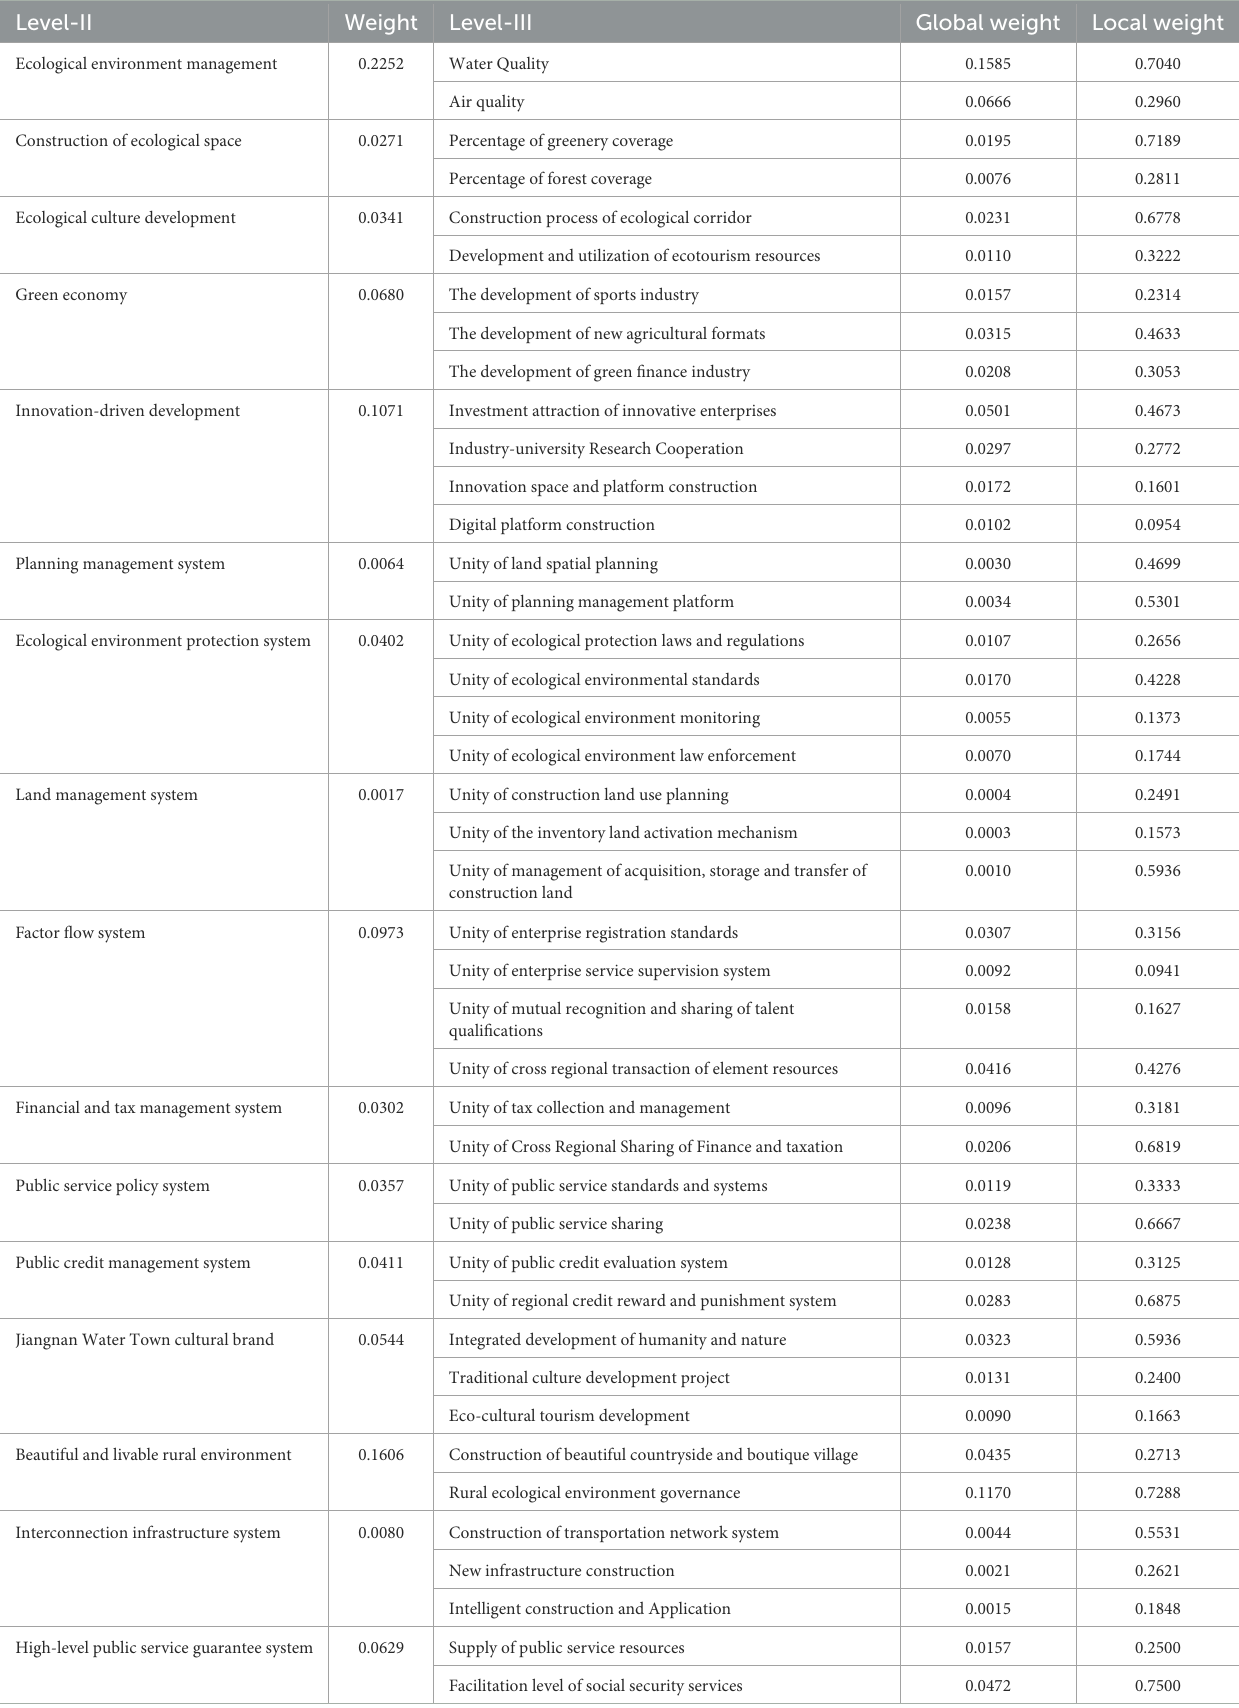
TABLE 3 Weight of high-quality development evaluation indicators of integrated development demonstration